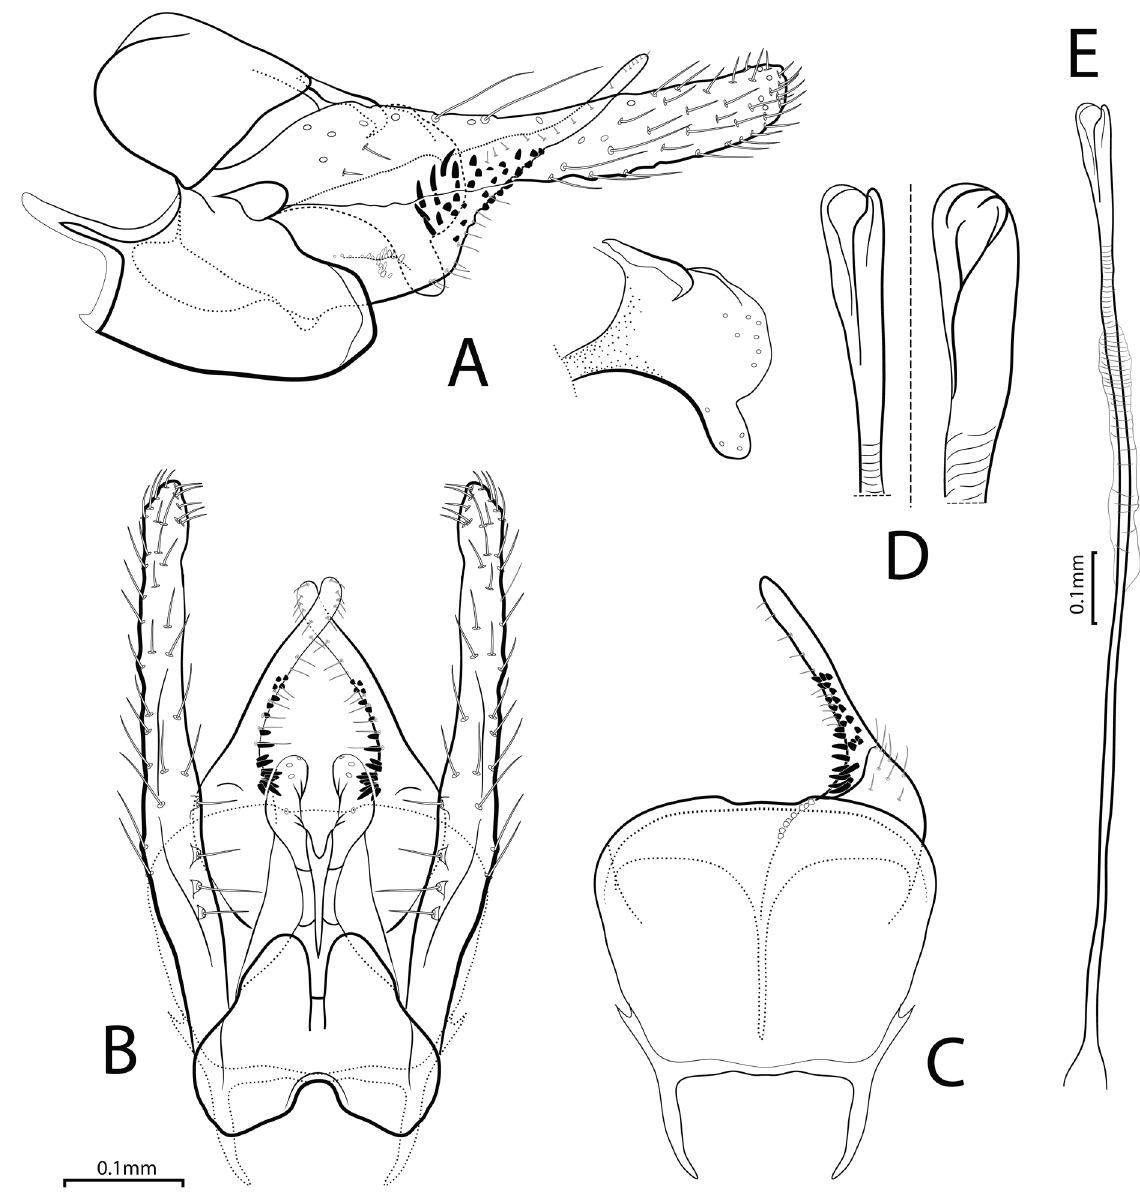
Fig. 7. Xiphocentron matsigenka sp. nov., holotype, male genitalia (MUSM-ENT-0320566). A . Lateral view, with detail of paraproct. B . Dorsal view. C . Ventral view. D . Phallus, dorsal and lateral views, respectively. E . Phallus in full length, dorsal